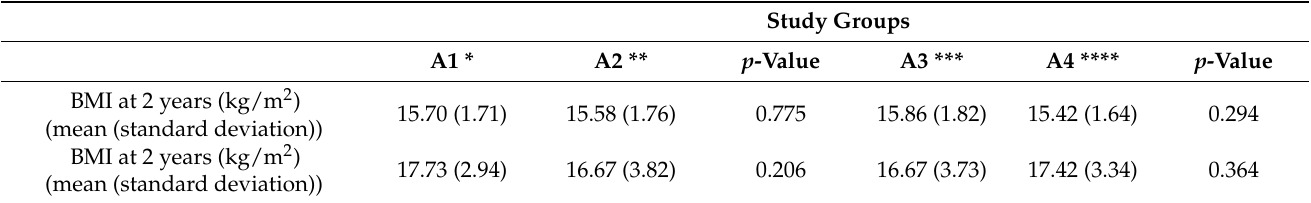
Table 3. BMI distribution of children born VPN according to the type and quantity of milk feeds.